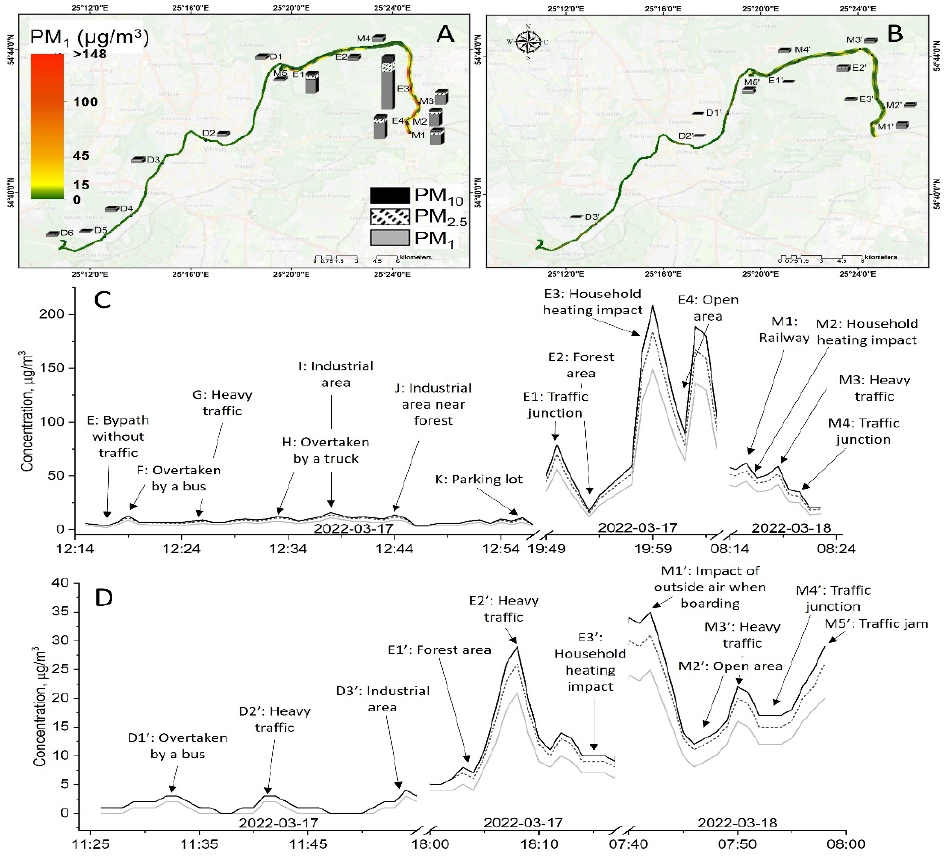
Figure 5. Spatial distribution of BC and PM concentrations for the route home–FTMC1–FTMC2 outside the car ( A ) and inside the car ( B ). Coloured line in the map marks PM 1 concentration, columns next to the route mark concentrations of PM 1 , PM 2.5 , PM 10 . Time series of PM concentrations outside the car ( C ) and inside the car ( D ).